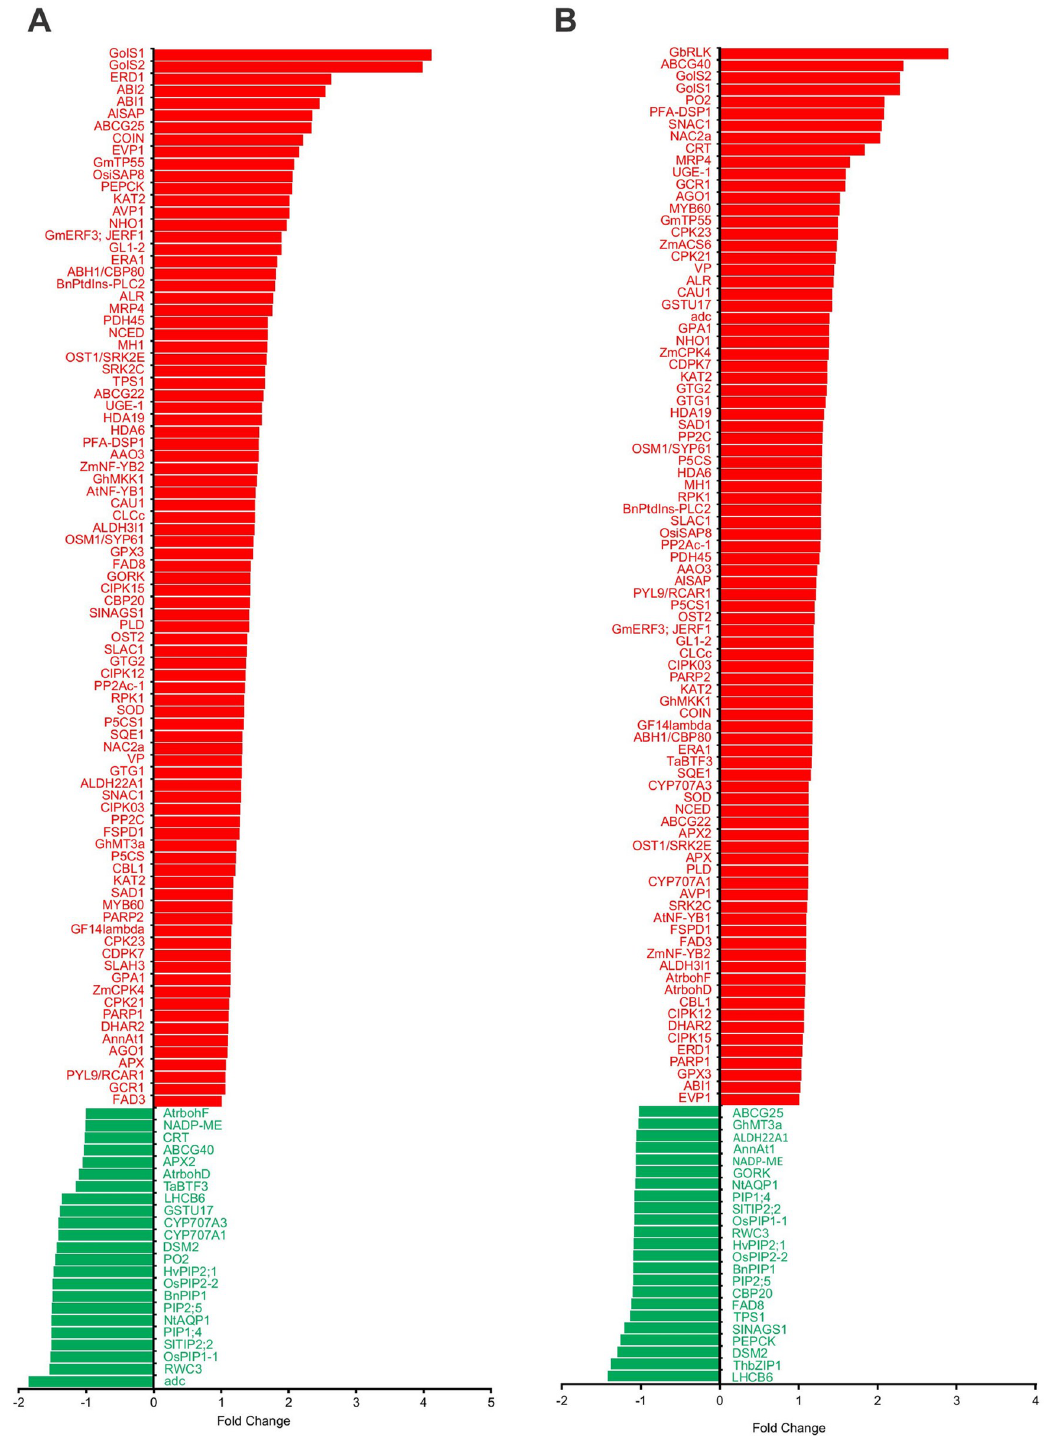
Fig 6. Differential expression pattern (fold change) of the genes from droughtDB in A. drought sensitive (1627) and B. drought tolerant (1656) onion genotypes under drought stress.